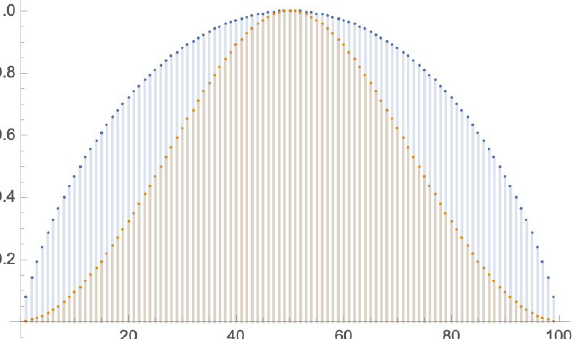
Figure 4. Shannon’s entropy H with Ω = 100, blue discrete plot for l 1 sampling and yellow discrete plot l 2